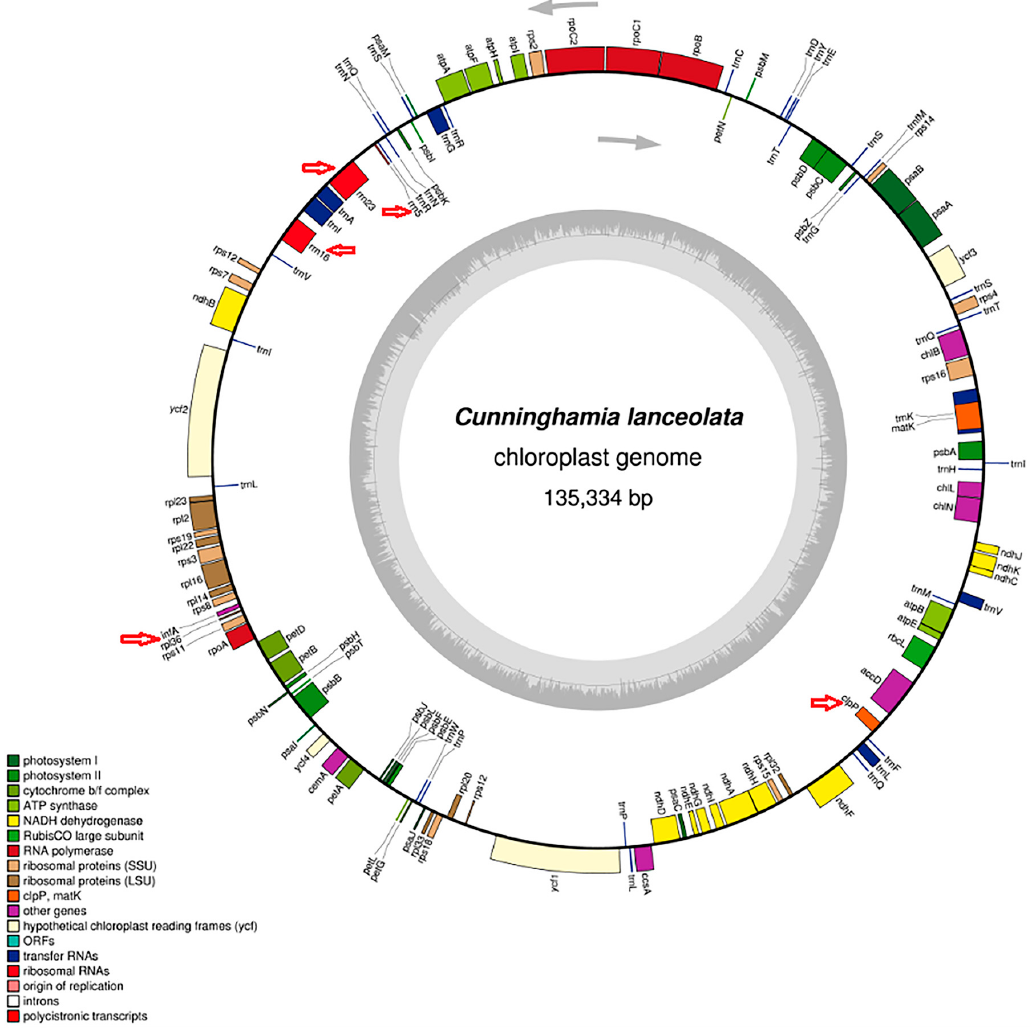
Figure 1. The Cunninghamia lanceolata sequences (NC_021437) were re-annotated using DOGMA [33]. The complete genome contains 121 genes. The graphical map of C. lanceolata was then generated by OGDRAW [34]. Red arrows indicate new defined genes, including two protein-coding and three rRNA genes.